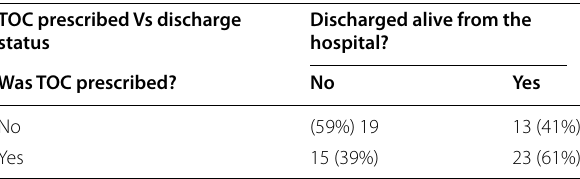
Figure 1 Run chart for the QIP During mid-February 21, our Covid admissions had reduced sig- nificantly, and an eligible patient was missed. Viral screening as part of the SOP was done in only 9 (23.7%) of patients given TOC. This may have been related to poor buy-in from the ICU staff. Although patients who got TOC showed less mortality (Table 1), it was not found to be statistically significant in this small sample.